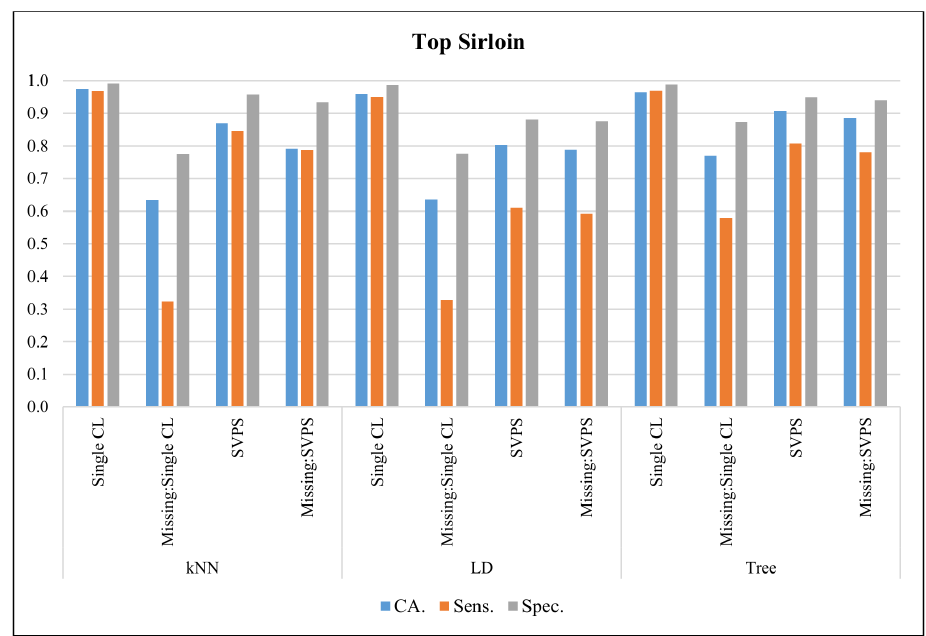
Figure 15. Classification results for Top Sirloin